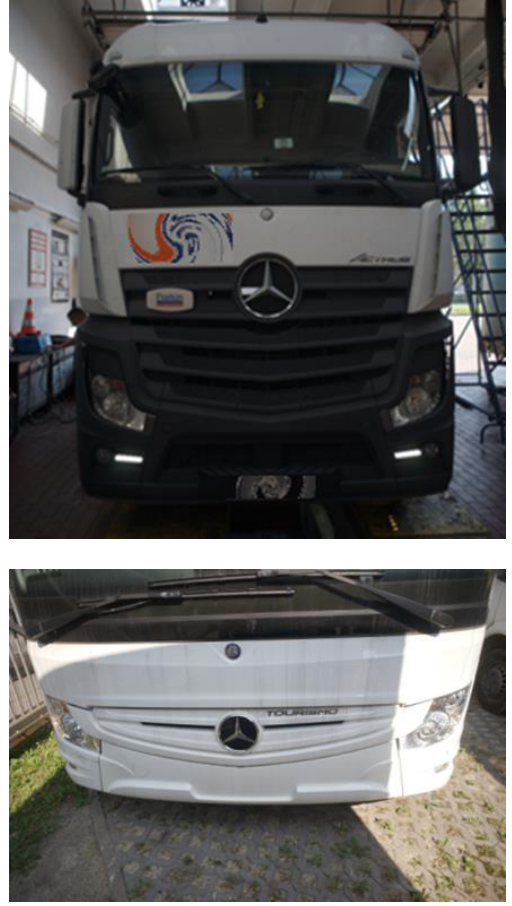
Fig. 4. View of the outlet of the exhaust system – Mercedes Tourismo coach Figures 5 and 6 show the schemes for measuring the volumetric concentration of carbon dioxide CO and oxy- 2 gen O in the exhaust gas for both tested vehicles at 2